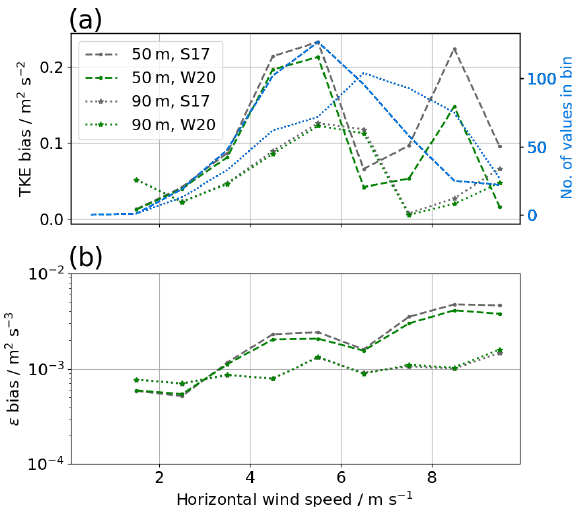
Figure 8. Difference of the lidar retrieval of TKE (a) and the TKE dissipation rate (b) compared to the sonic anemometer as a function of wind speed.